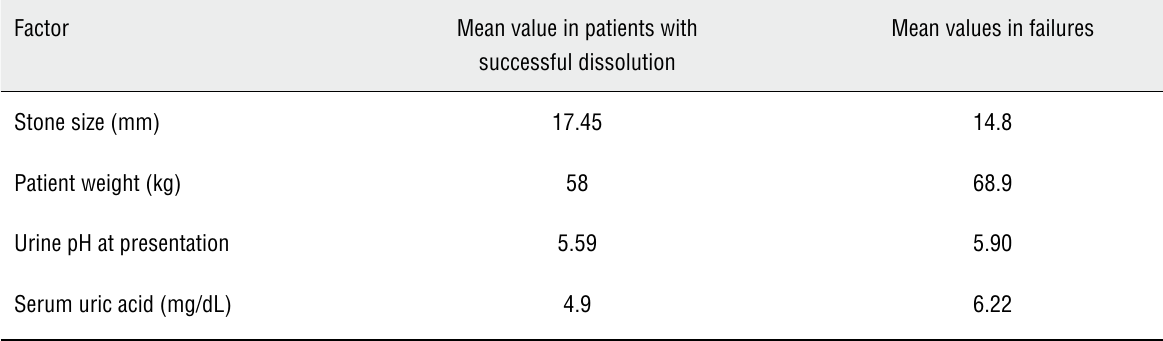
Table 3 - Comparison of baseline factors in patients undergoing successful dissolution and failures.